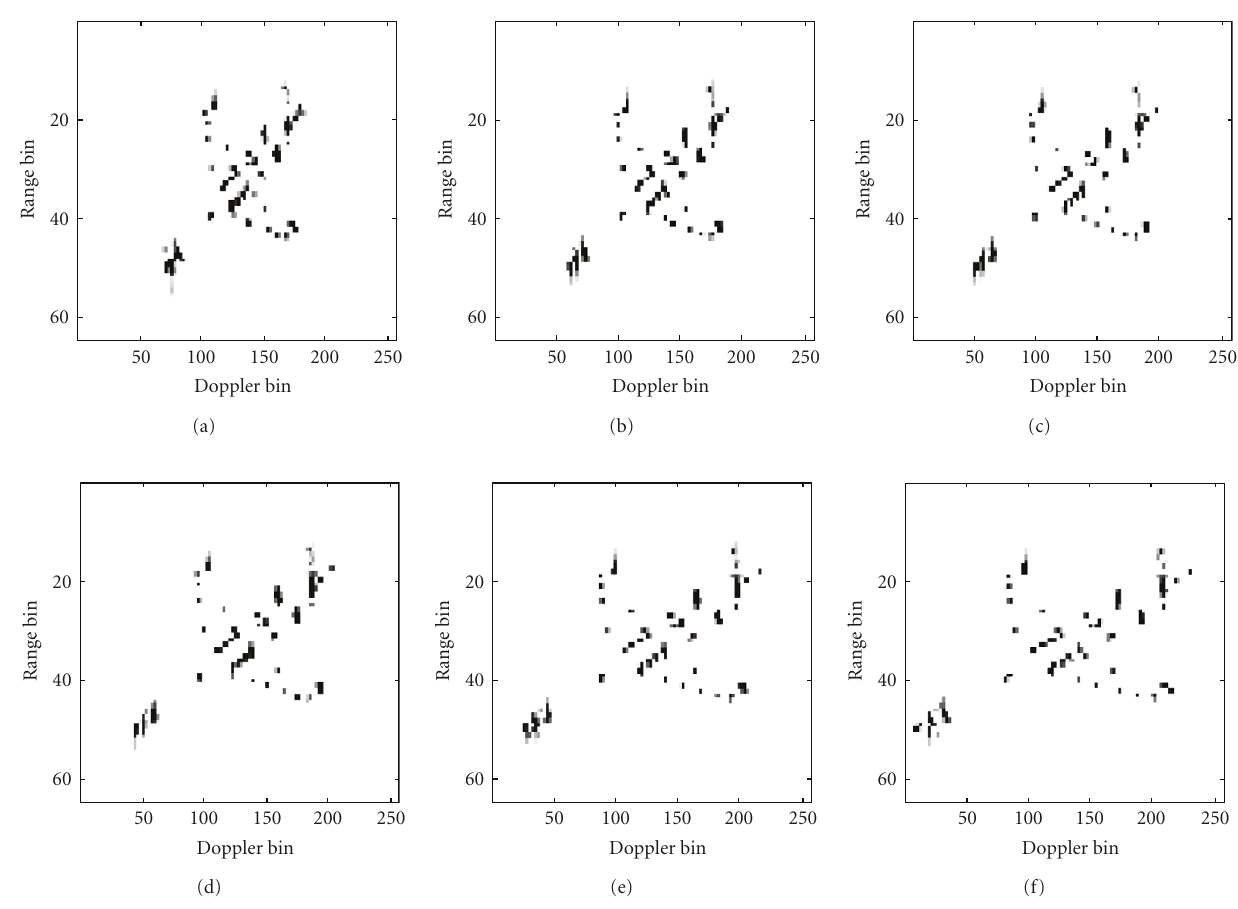
Figure 7: ISAR images of simulated data based on the MACD